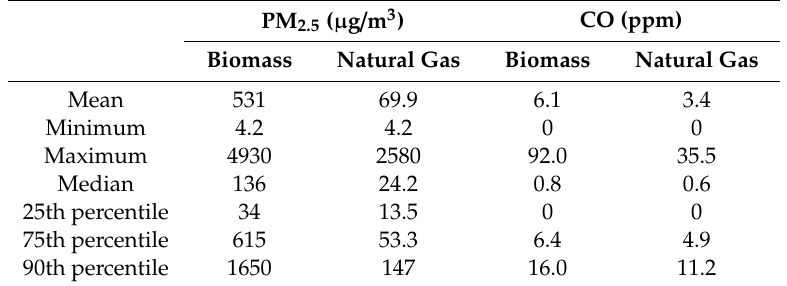
Table 2. Distribution of hourly mean concentrations of PM 2.5 and CO in kitchens of households using biomass and natural gas for